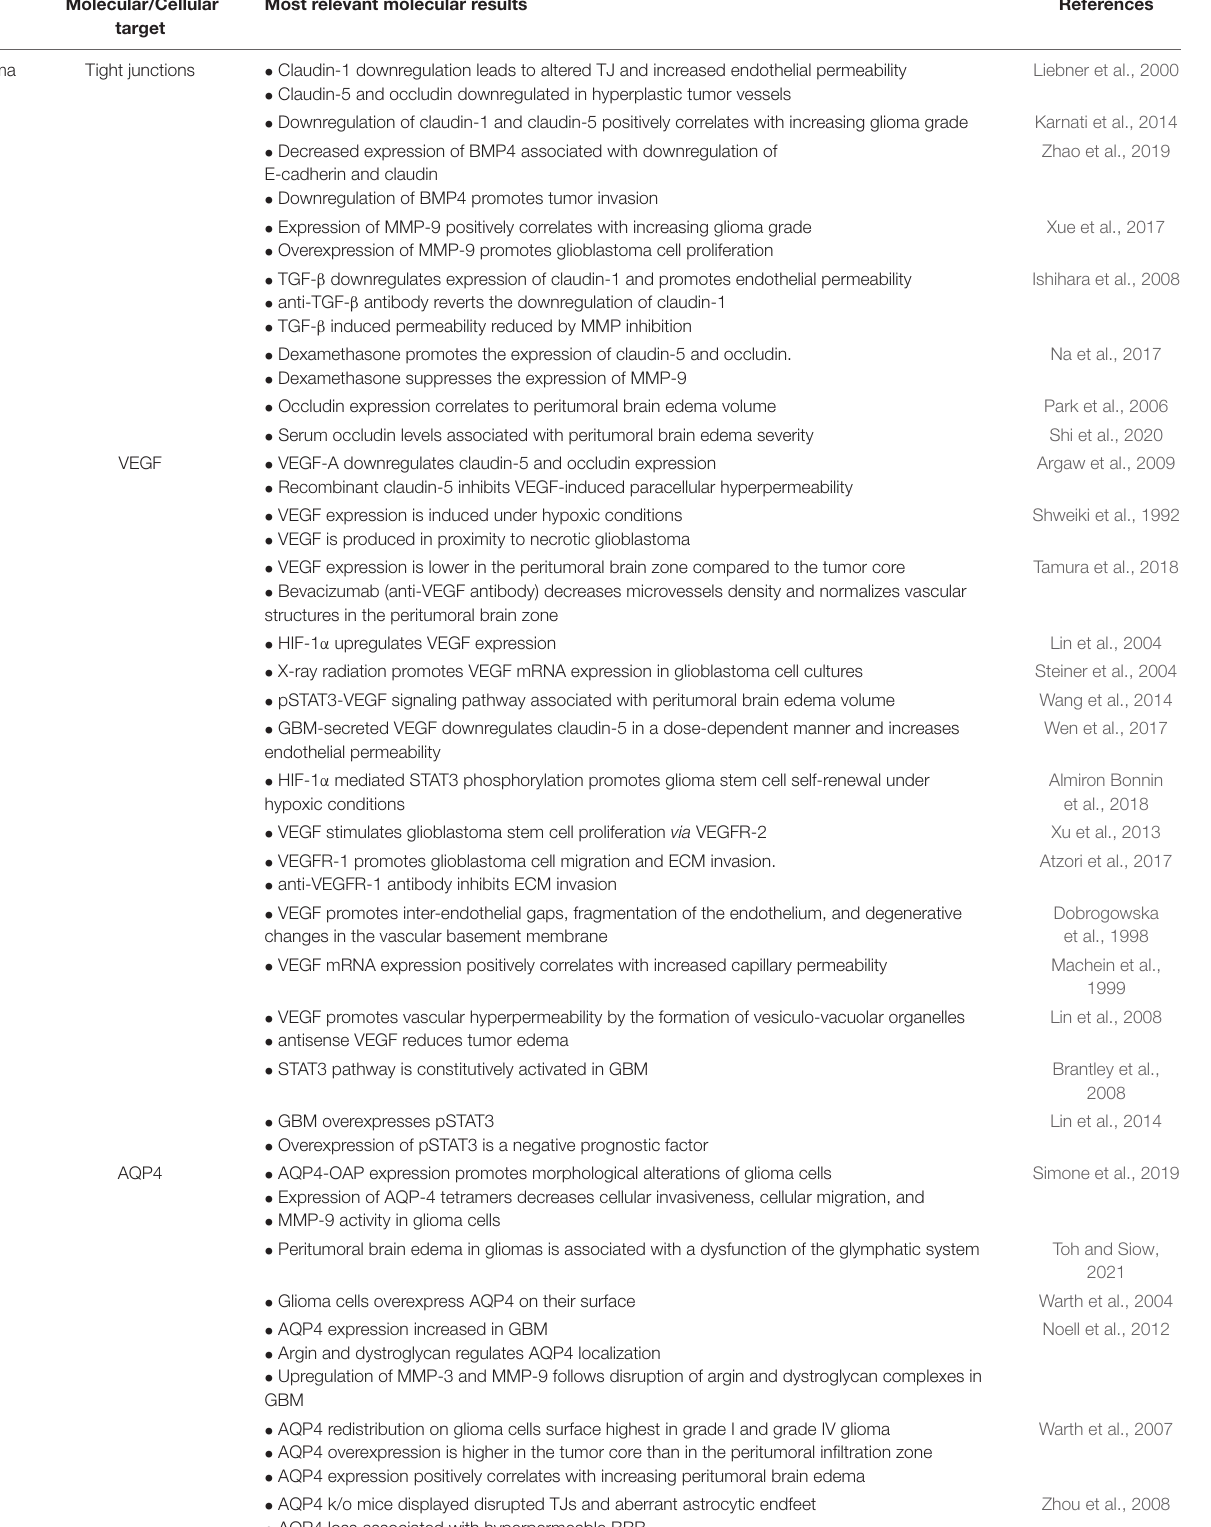
TABLE 1 | Table summarizing molecular and cellular changes in edematous brain tissue around glioblastoma, brain metastasis, lymphoma, and abscess. Molecular/Cellular Most relevant molecular target